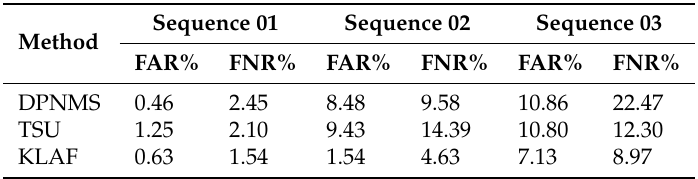
Table 2. Detection performance for our dataset.